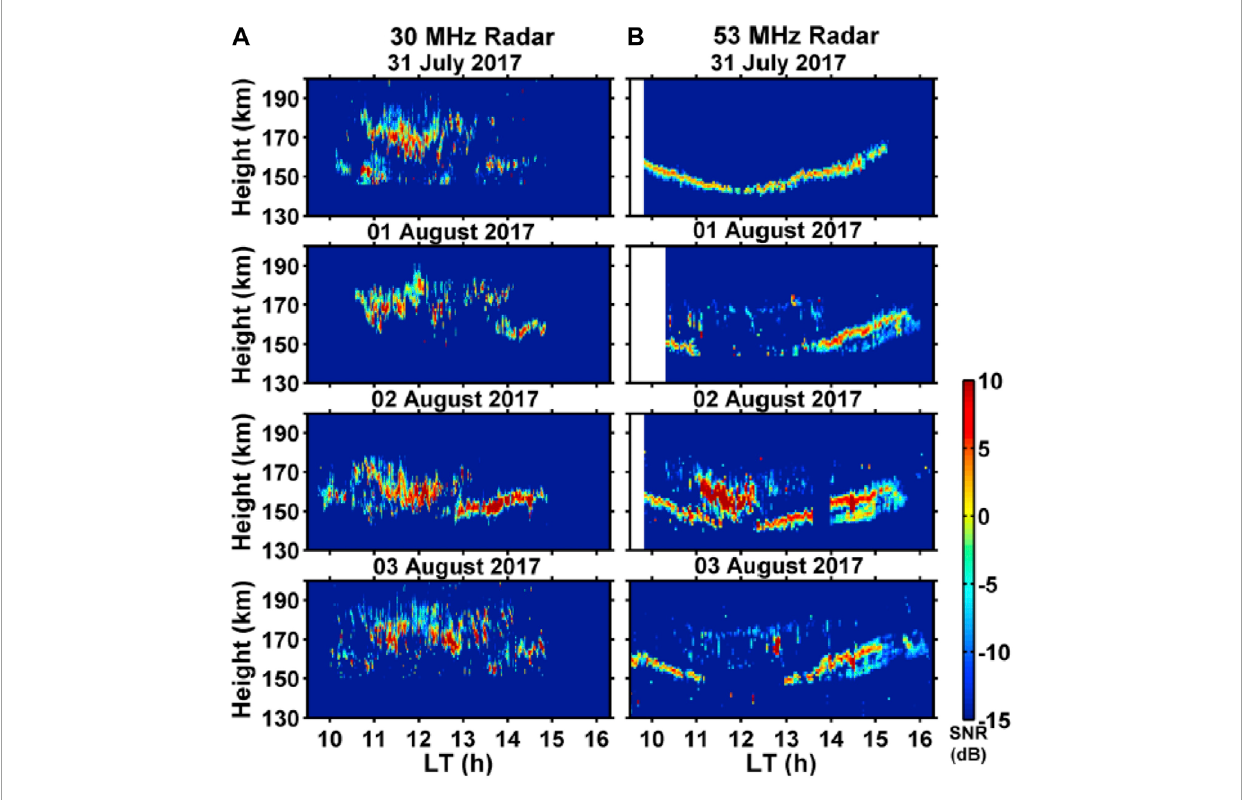
FIGURE 9 Altitude-time SNR co-located observations of 150-km echoes between 31-July-2017 and 03-August-2017 over Gadanki at: (A) 30 MHz and (B) 53 MHz (adapted from Patra et al., 2018, Figure 1).